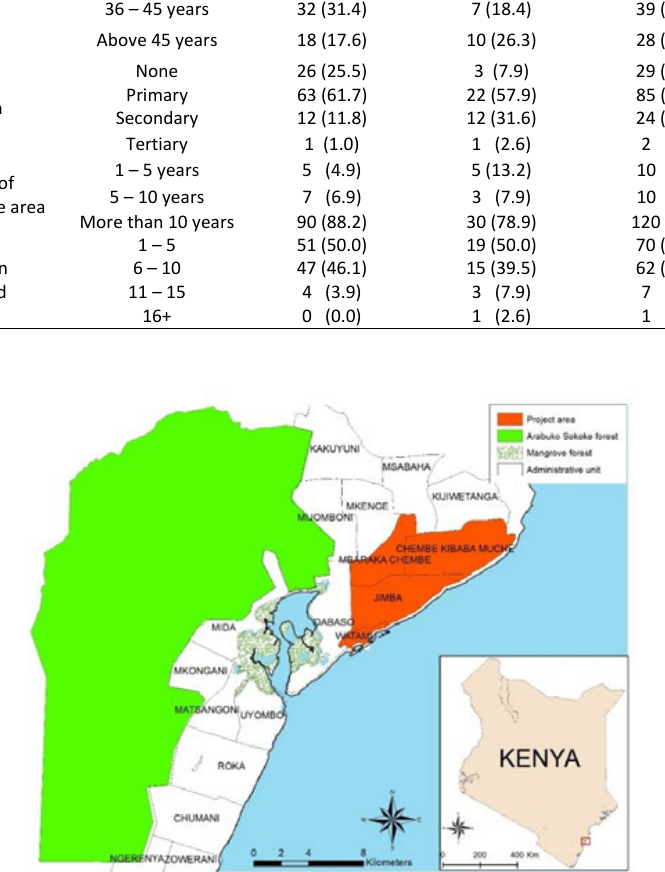
Fig. 1: Geographic location of the study area in Watamu of Kenya